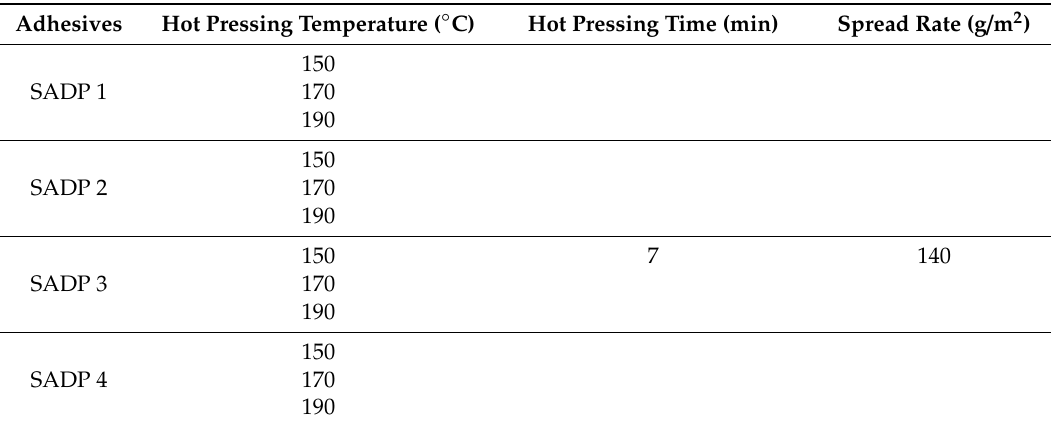
Table 2. Manufacture conditions of the